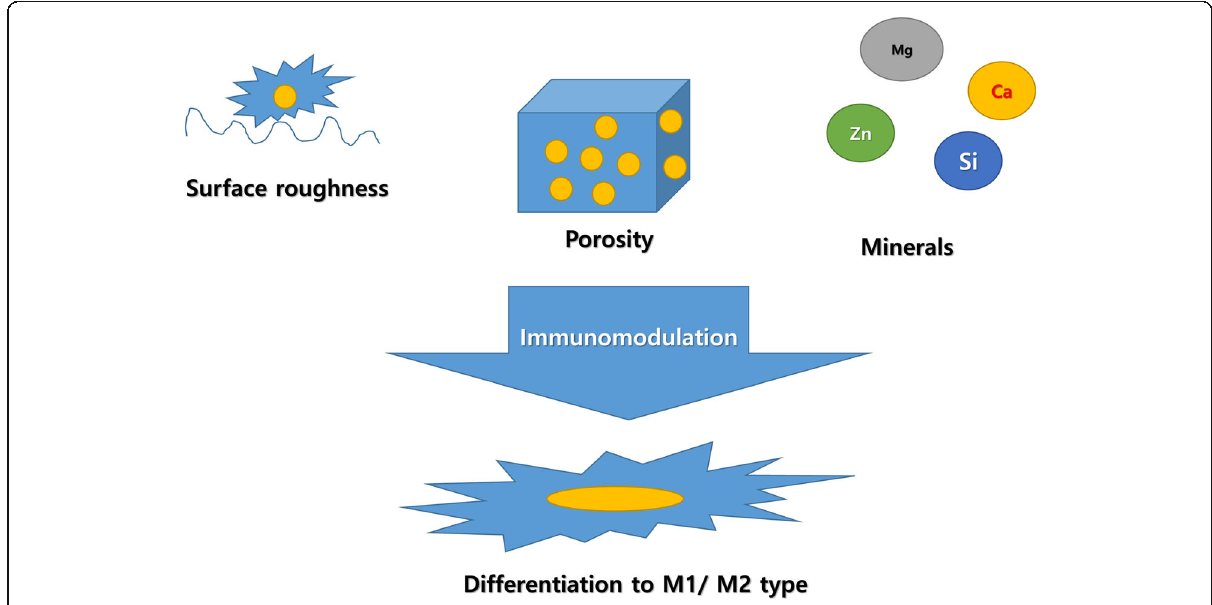
Fig. 1 Classical way of immunomodulation. The immunomodulation technique can be applied to achieve a desirable host response to grafts. Modification of surface roughness and porosity is a simple method for immunomodulation. Some trace elements have also been considered for helping wound